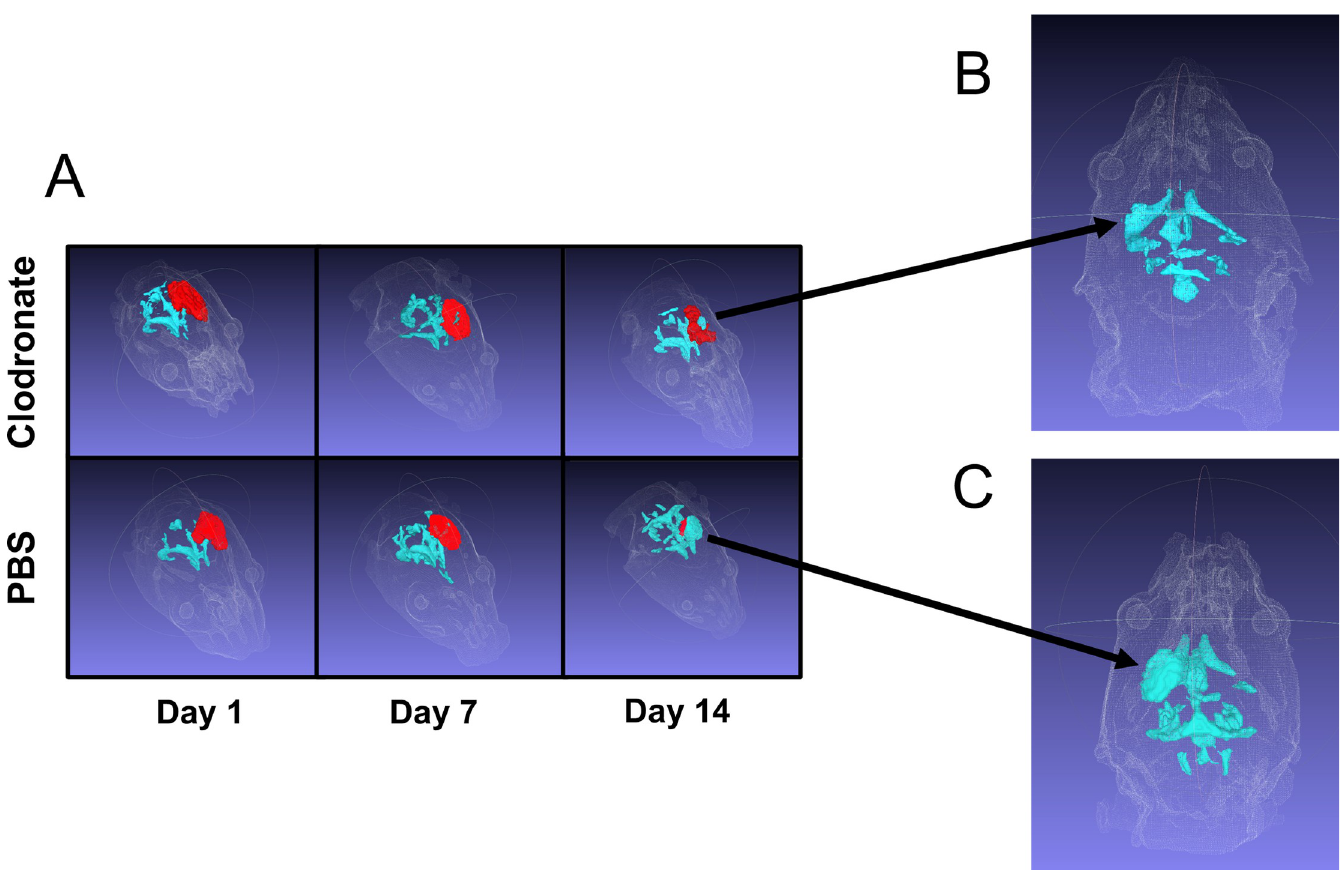
Fig 4. 3D renderings of ventricle enlargement in monocyte-depleted vs. sham-depleted mice after traumatic brain injury. A) Shown in RED is the extent of traumatically injured tissue at post injury days 1, 7, and 14. Shown in light BLUE is the ventricle size. There is a progressive increase in ventricle size and decrease in injured tissue indicating loss of brain tissue and replacement with cerebrospinal fluid over the course of injury. At 14 days post-TBI the increase in ventricle size between B) monocyte-depleted mice (5.3 ± 0.9mm 3 ) and C) sham-depleted mice (13.2 ± 3.1mm 3 ) is markedly attenuated ( p = 0.02) indicating preservation of the injured neuronal